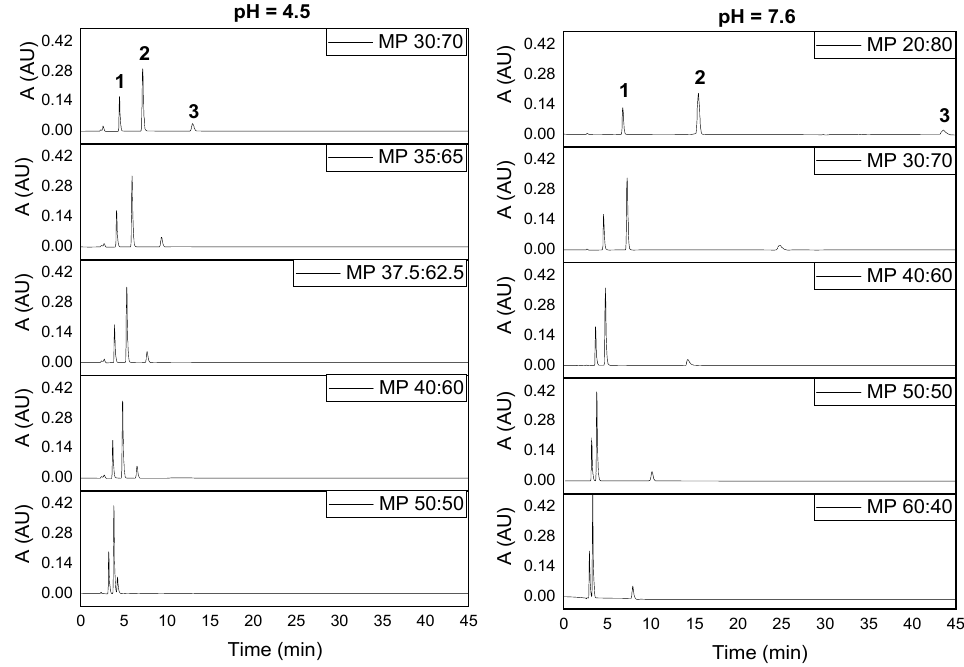
Figure 1. Chromatograms at basic and acidic pHs for several methanol/phosphate ratios (% MeOH/% phosphate solution, v/v ) of the mobile phase (MP) (1: paracetamol; 2: caffeine; 3: tramadol). Paracetamol (50 µ g/mL), caffeine (50 µ g/mL) and tramadol (50 µ g/mL). (A: absorbance; AU: arbitrary units).